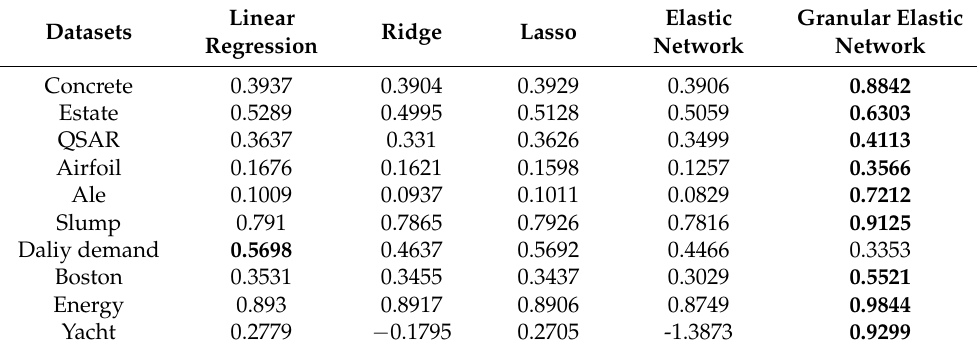
Table 3. The coefficient of determination results for granular elastic network regression and classical regression